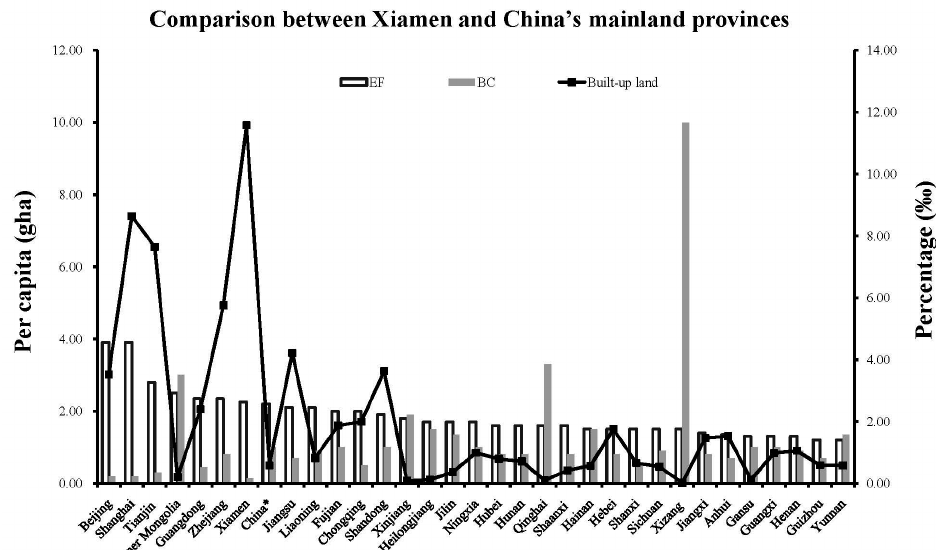
Figure 9. Comparison between Xiamen City and China’s provinces and municipalities (figure drawn by the author)